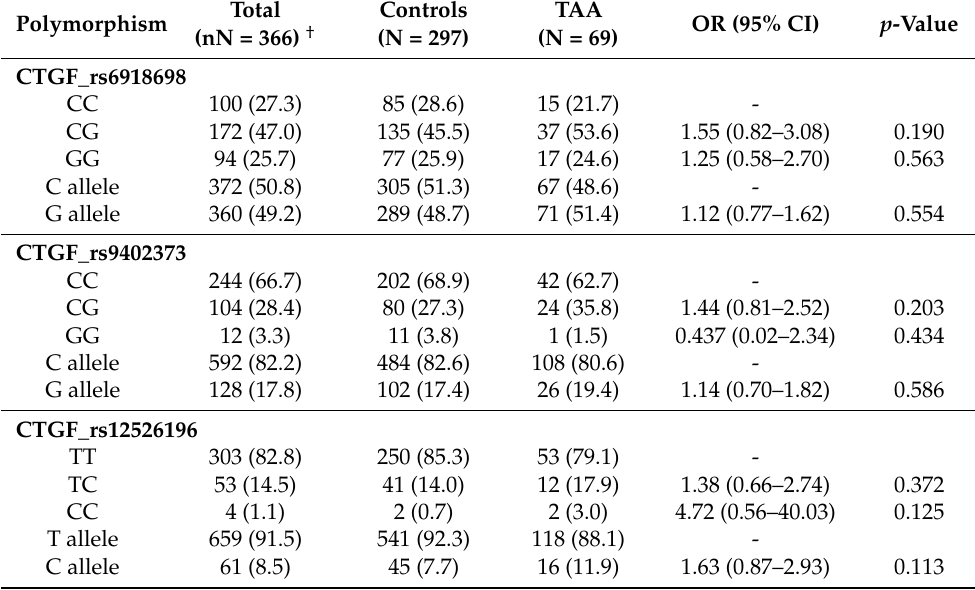
Table 2. Univariable logistic regression models for genotype and allele frequencies of the polymor- phisms in the study population, according to the presence of thoracic aortic aneurysm.